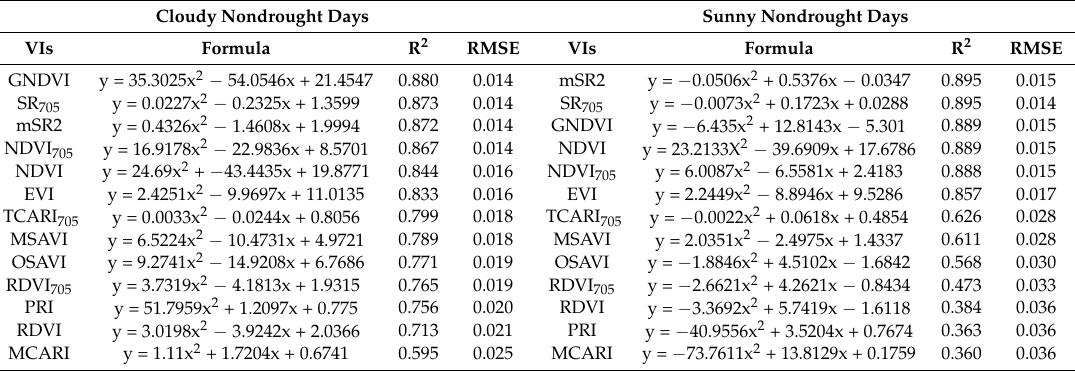
Table 4. Regression equations between the FPAR (y) and VIs (x) on sunny days and cloudy days without drought